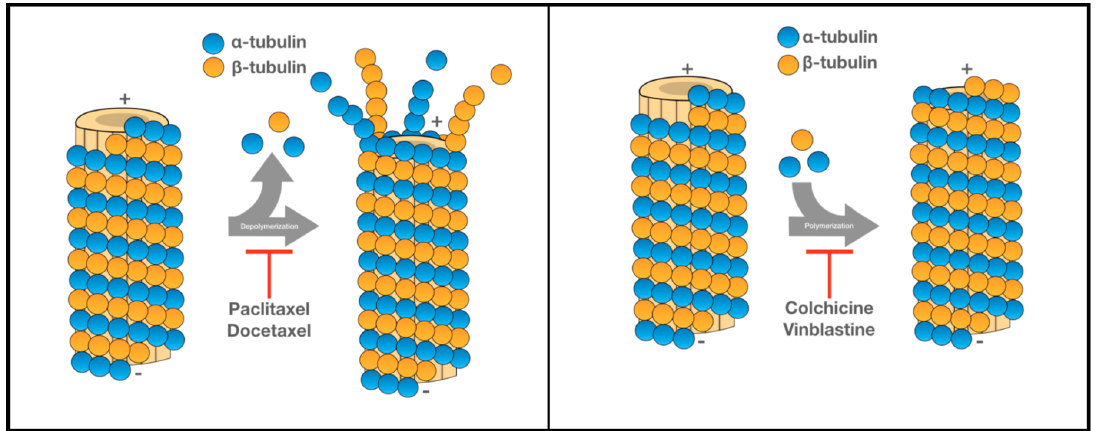
Figure 1. Demonstrates how the tubulin inhibitors affect the microtubules by preventing depolymerization or polymerization. Panel left illustrates the effects of paclitaxel and docetaxel (depolymerization inhibitors), while panel right illustrates the effects of colchicine and vinblastine (polymerization inhibitors).